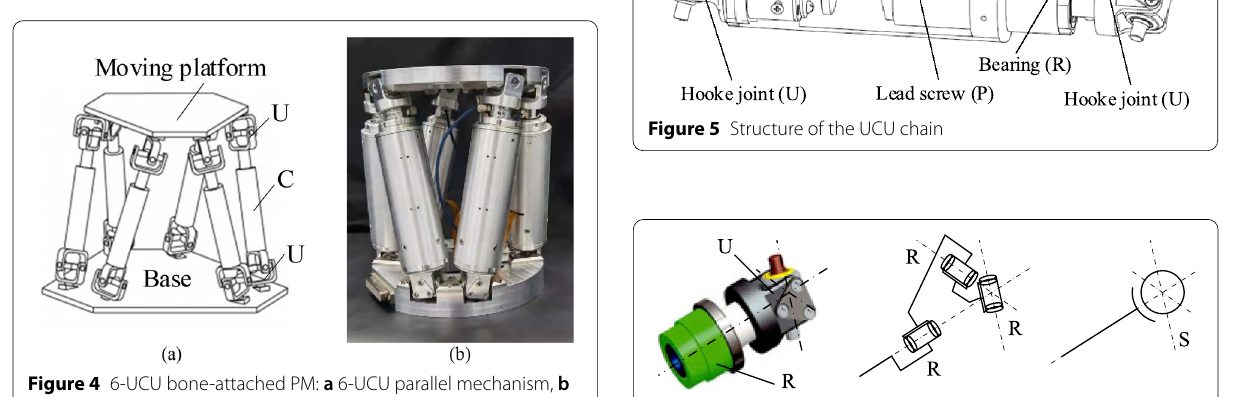
Figure 6 Equivalent spherical